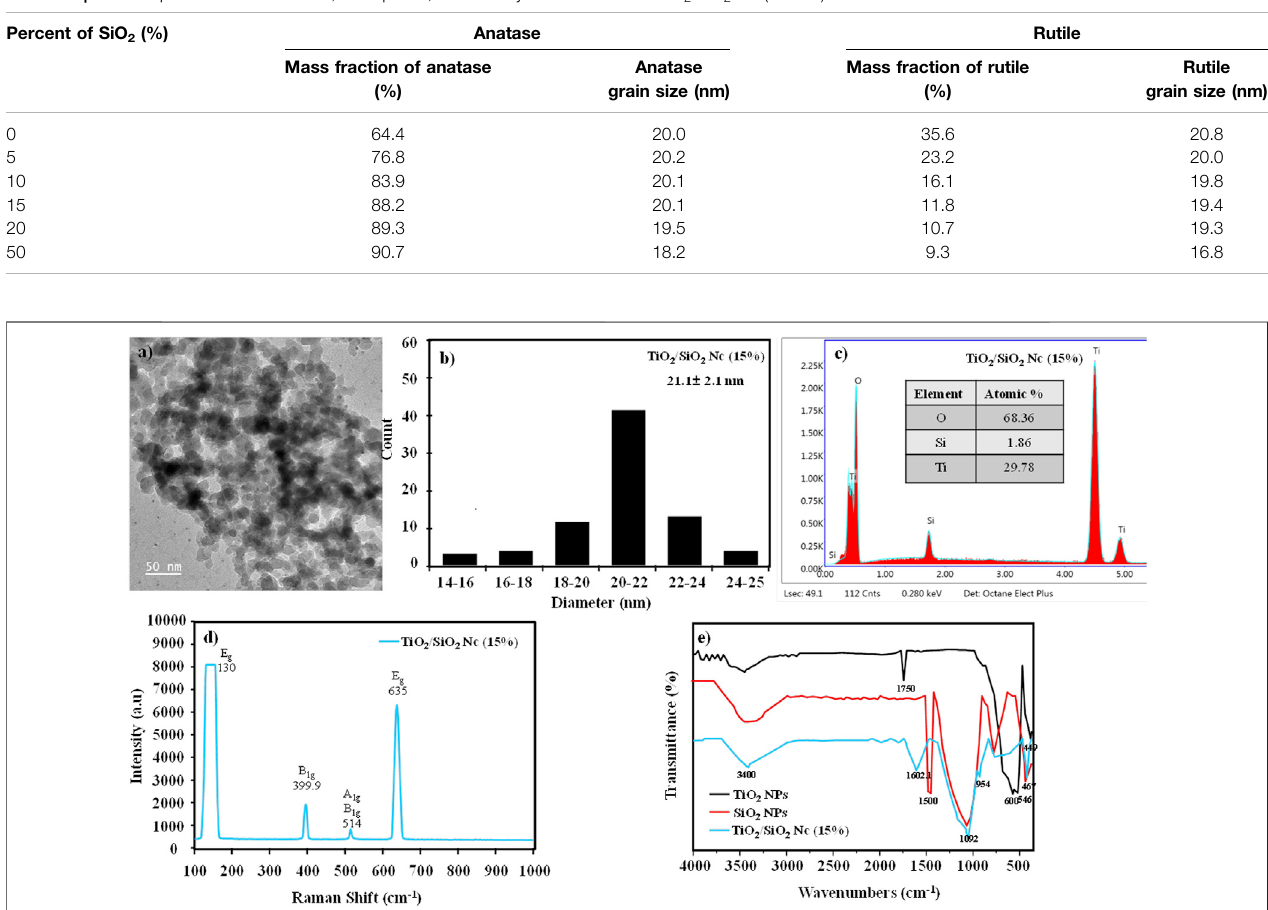
FIGURE4|(A,B) Transmission electronmicroscopy(TEM)and sizedistribution ofTiO 2 /SiO 2 Nc(15%); (C) EnergydispersiveX-Ray (EDX)spectraofTiO 2 /SiO 2 Nc (15%); (D) Raman spectra of TiO 2 /SiO 2 Nc (15%); (E) FT-IR spectra of TiO 2 /SiO 2 Nc (15%) in comparison with the TiO 2 NPs, and SiO 2 NPs.